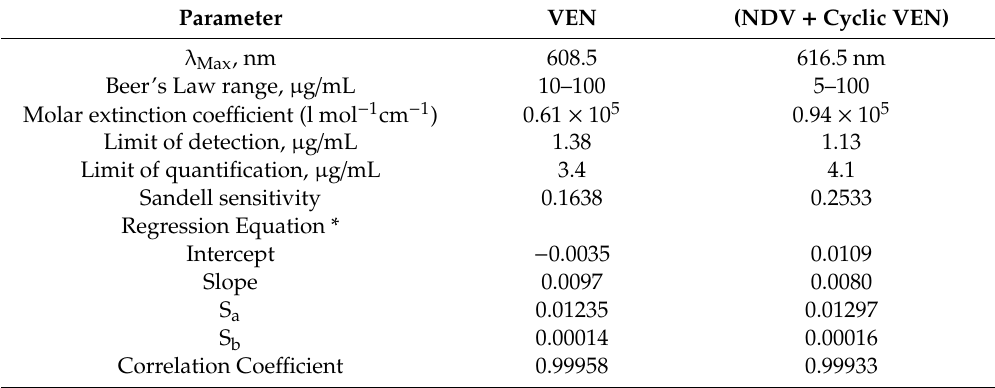
Table 1. Regression parameters and derived limits and coe ffi cients of the proposed analytical